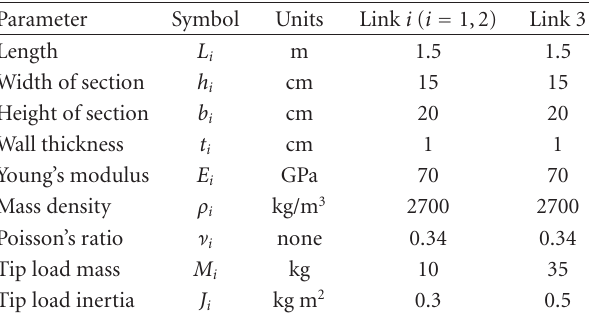
Table 8: Parameters of the adopted industrial